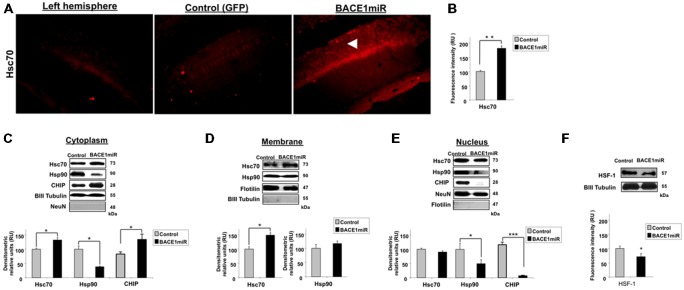
BACE1miR decreases HSF-1, upregulates Hsc70 and induces differential cellular distribution of Hsc70 and Hsp90 in the hippocampus of 3xTg-AD mice. (A) Hippocampi of 18-month-old 3xTg-AD mice at 12 months after injection with AAV2/5-BACE1miR (BACE1miR) or AAV2/5-GFP (GFP). Immunofluorescence of Hsc70 in the CA1 region of 3xTg-AD mice. The white arrowheads show a significant increase in Hsc70 protein expression in the CA1 region that was injected with AAV2/5.BACE1miR compared to the left hemisphere (not injected) and to a right hemisphere injected with AAV2/5-GFP (control). Red: Alexa 594. 10X magnification, scale bar: 20 μm. n = 3. (B) Graph of Hsc70 fluorescence intensity (red channel) in the CA1 area showing a significant increase of Hsc70 expression in BACE1miR-treated mice compared to the left hemisphere (not injected) and right hemisphere injected with AAV2/5-GFP (control). Quantification was performed using image Scope Pro software (Media Cybernetics); RU = relative units. n = 3, *p < 0.05. (C) Cellular fractions from the hippocampi of 15-month-old 3xTg-AD mice that were treated with AAV2/5-BACE1miR (BACE1miR) or AAV2/5-GFP (GFP) for three weeks. Hsc70, CHIP and Hsp90 levels in the (C) cytoplasm, (D) membrane and (E) nuclear fractions. (F) HSF-1 protein expression in the hippocampi of 15-month-old 3xTg-AD mice at three weeks after injection with AAV2/5-BACE1miR (BACE1miR) or AAV2/5-GFP (GFP). Representative blots are shown. βIII tubulin, flotillin and NeuN were used as loading controls or as fraction controls. Densitometric quantification was performed; RU = relative units. n = 6, *p < 0.05, **p < 0.001, ***p < 0.0001.